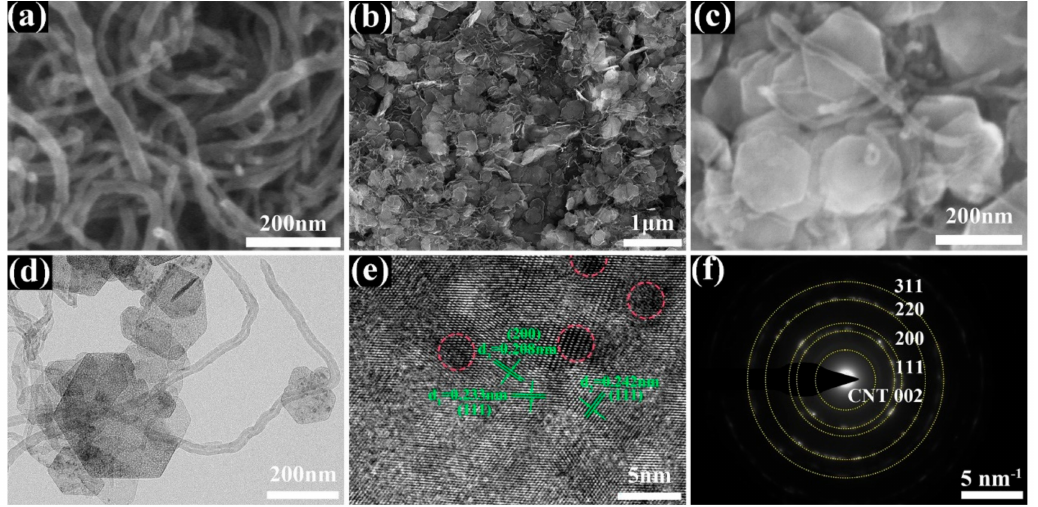
Figure 2. ( a – c ) SEM images of CNT and NiO/CNT, ( d ) TEM, ( e ) HRTEM images, ( f ) SAED pattern of